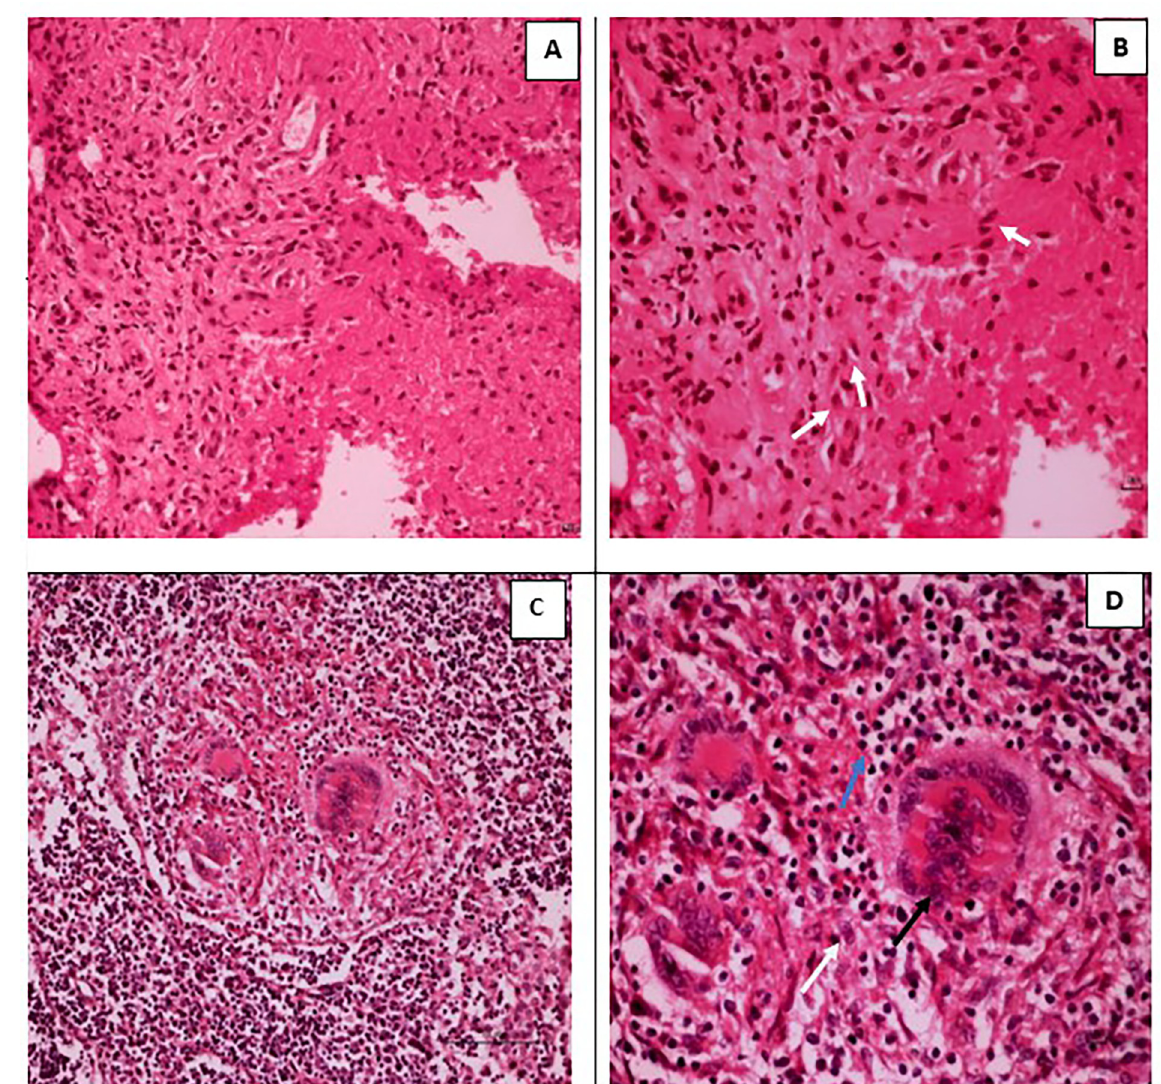
Fig 2. Hematoxylin & Eosin staining pattern in a tuberculous lymphadenitis case in a cell block (A,B) and a biopsy section (C,D). (A)10x, (B) 40x showing epithelioid cells (white arrow) and lymphocytes (blue arrow). (C) 10x, (D) 40x, showing epithelioid cells (white arrow), multinucleated giant cells (black arrow), and lymphocytes (blue